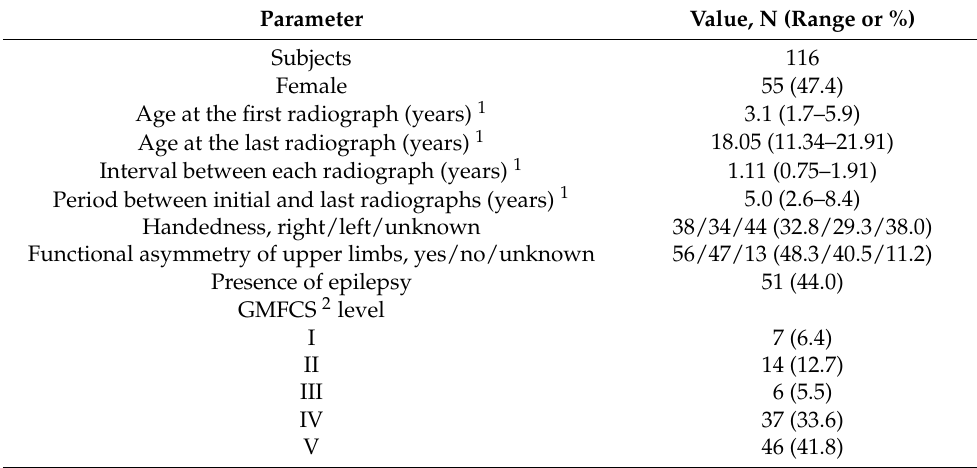
Table 1. Participants’ demographic